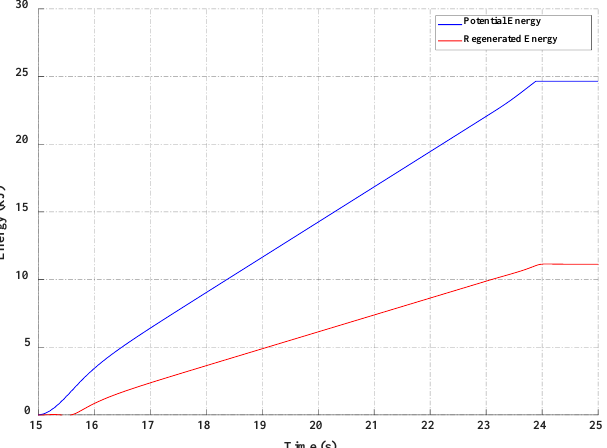
Figure 15. Energy analysis of the proposed ERS.